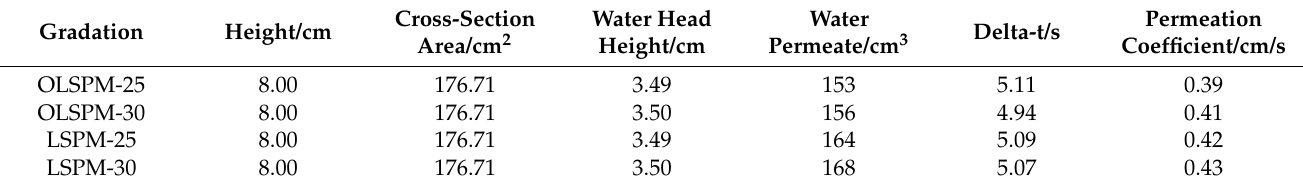
Table 8. The average values of test parameters and permeability coefficient of different mixtures.